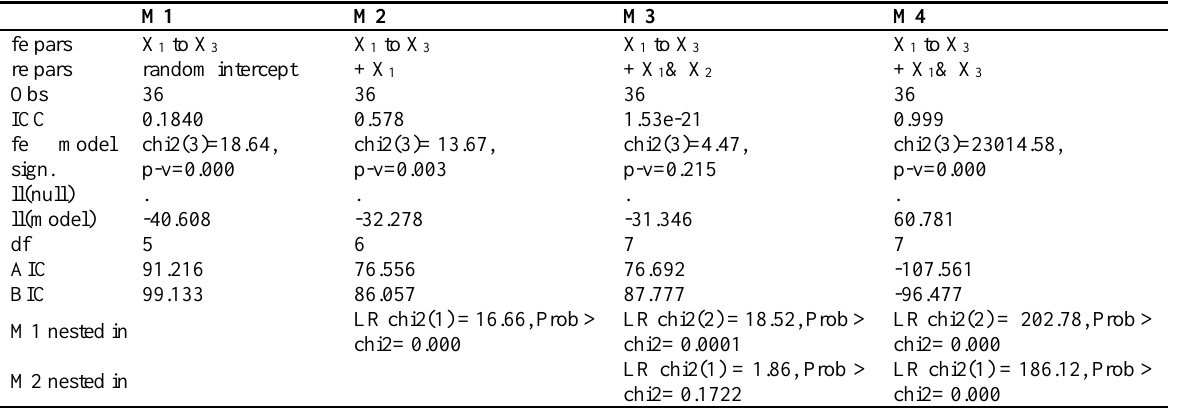
Table 8 : Model Summary and Likelihood Ratio Tests